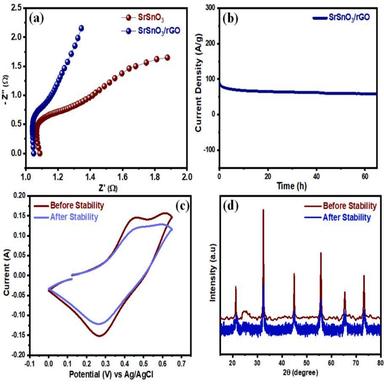
(a) EIS of SrSnO3 and SrSnO3/rGO nanohybrid (b) Chronoamperometry curve of SrSnO3/rGO nanohybrid (c) CV stability curve of SrSnO3/rGO nanohybrid at 10 mV/s and (d) XRD stability of SrSnO3/rGO nanohybrid.